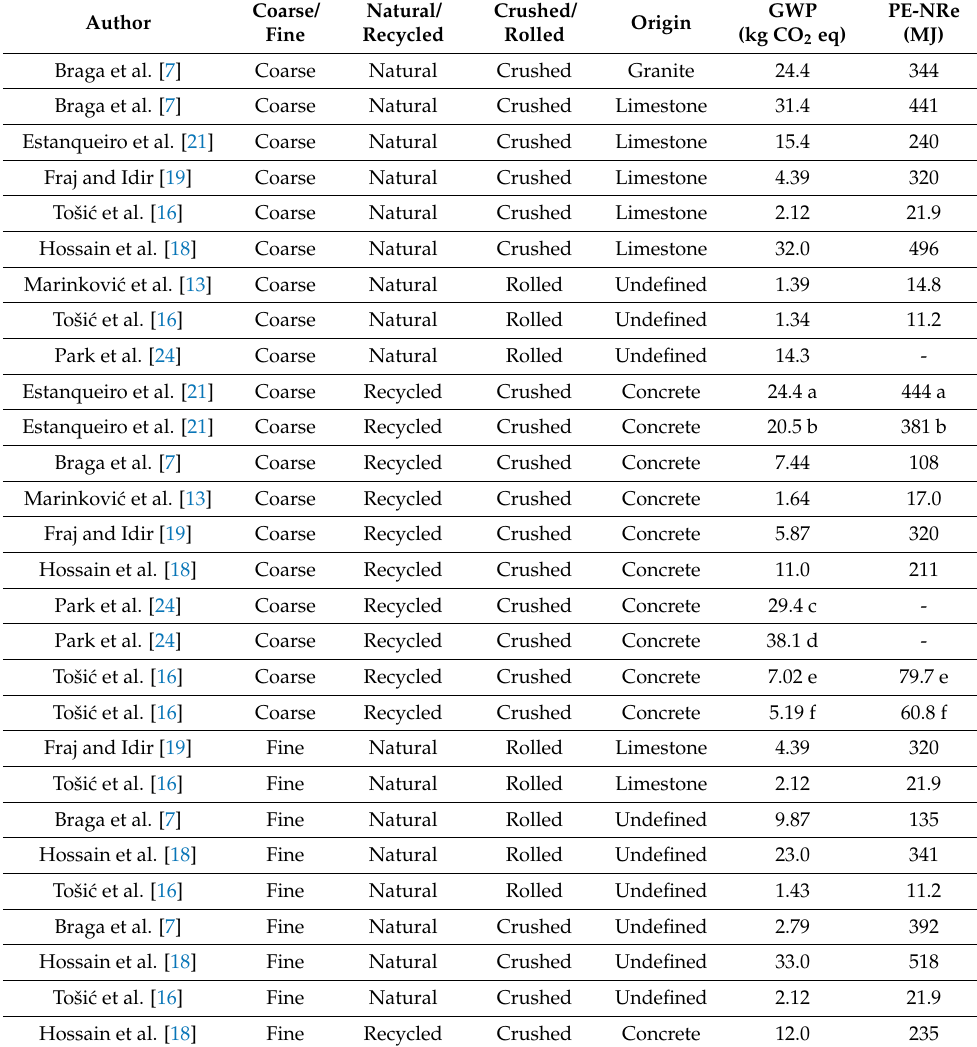
Table 5. Type of aggregates used in concrete and corresponding environmental impacts, from the literature (GWP, in kg CO 2 eq; PE-NRe, in